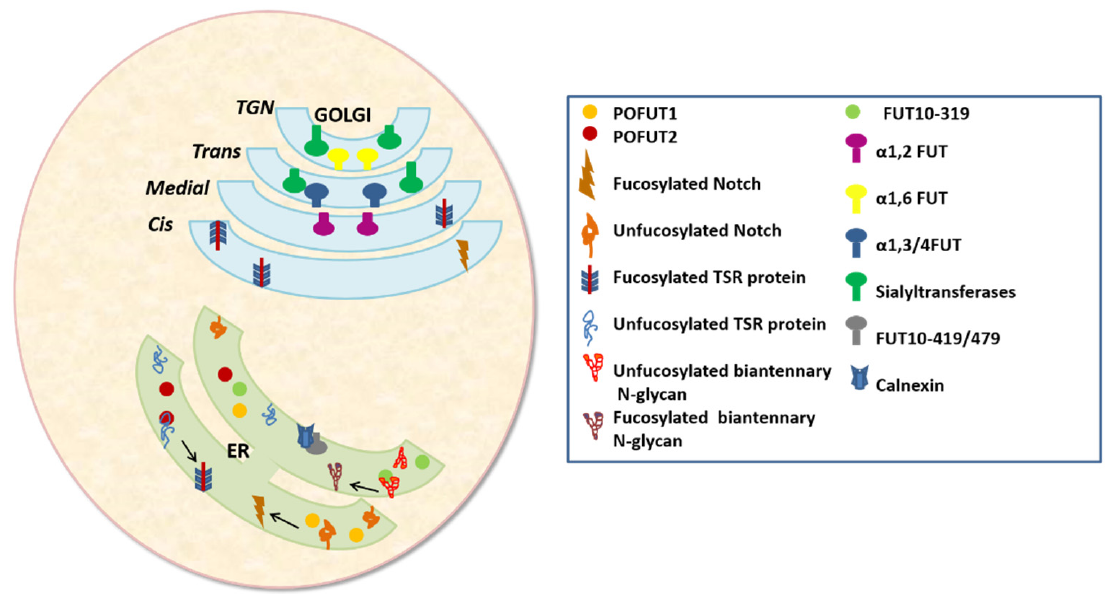
Figure 2. Cellular localization of STs and FUTs. α 1,2 FUT, α 1,3/4 FUT, α 1,6- FUT, and all STs are type II membrane proteins anchored at the Golgi, except for O-FUTs and FUT10, which are retained at the ER.FUT10-319 is reported to be a soluble protein, while FUT10-419/479 appear to be membrane-bound in the ER.